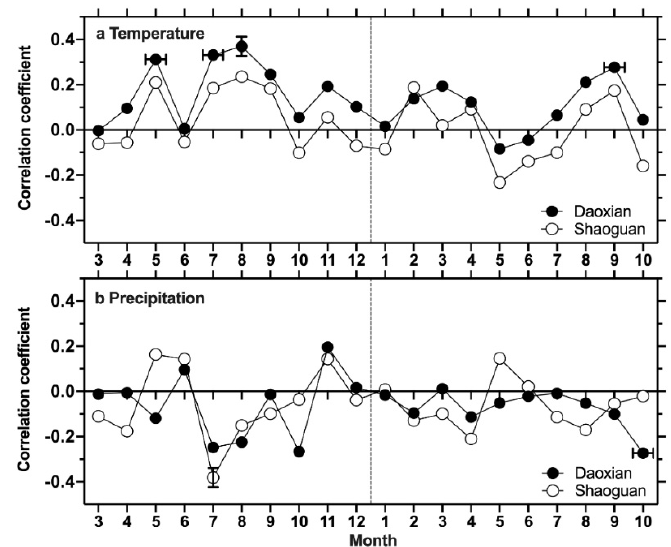
Figure 5. Correlation coefficients of the TRW chronology with ( a) monthly mean temperature and ( b) monthly total precipitation at Daoxian and Shaoguan meteorological stations from the previous March to the current October during their common period 1960–2014. Vertical dash lines separate previous and current year. Vertical mark denotes the 0.01 significance level. Horizontal mark denotes the 0.05 significance level.